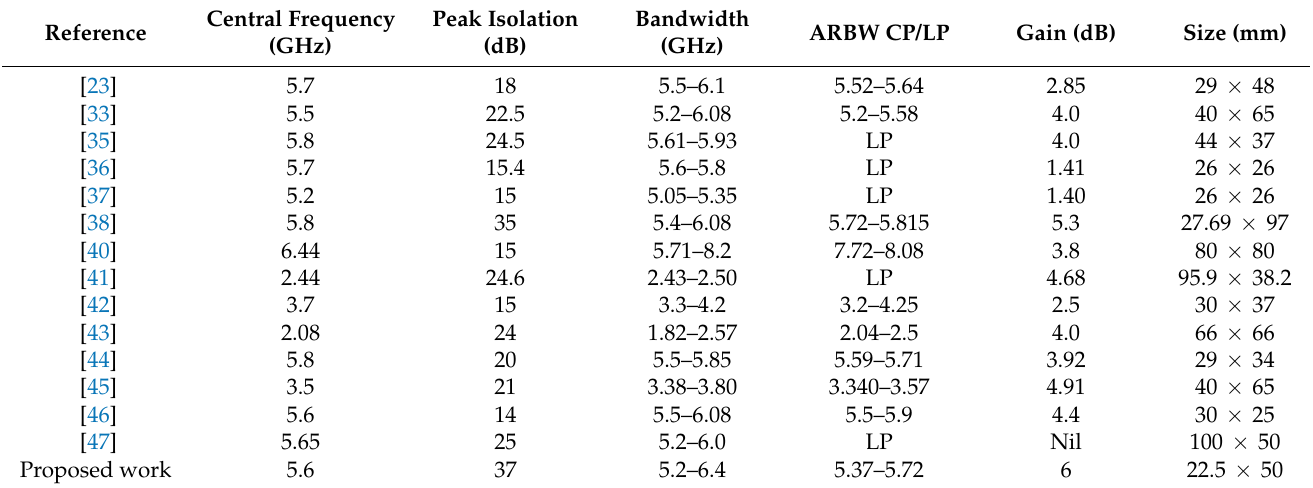
Table 2. Design parameter of the MIMO antenna circular